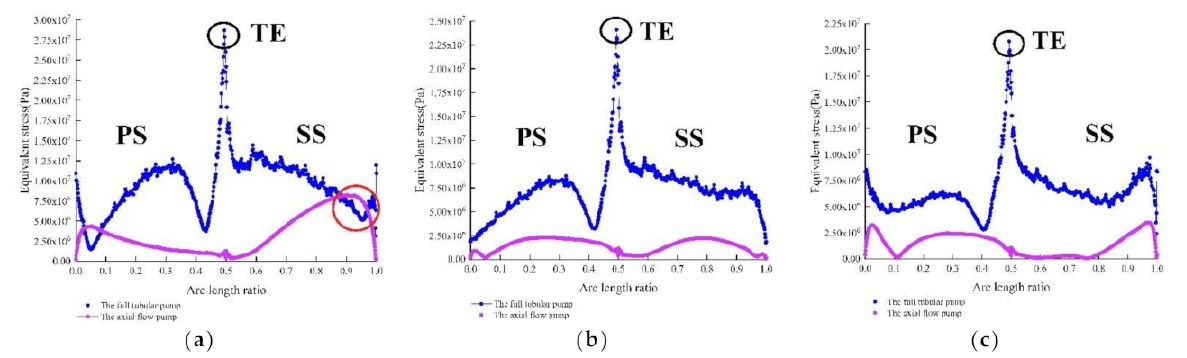
Figure 14. The stress distribution of the blade rim: ( a ) 0.8 Q bep , ( b ) Q bep , ( c ) 1.1 Q bep .